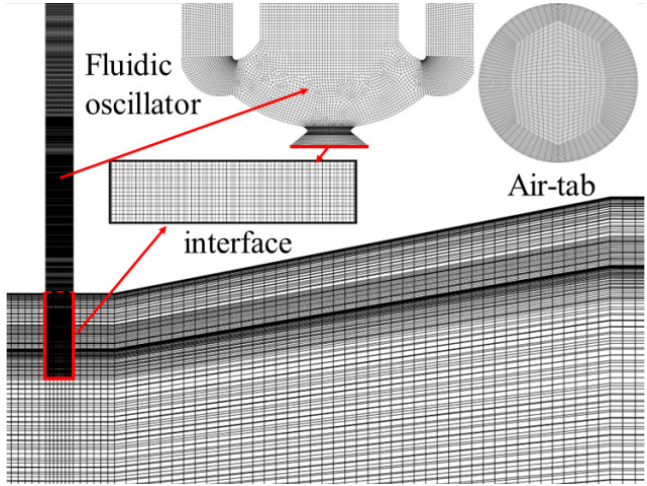
Figure 3. Computation grids.